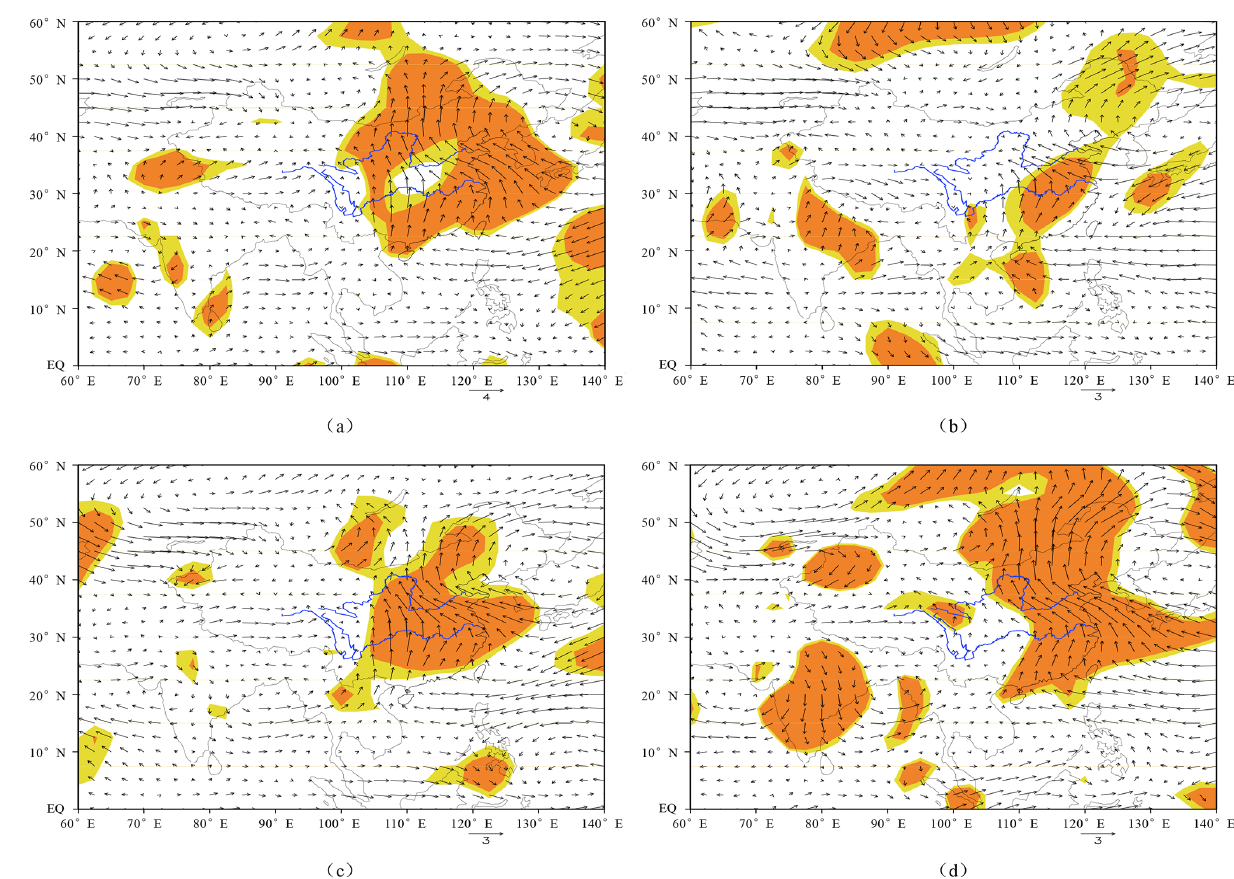
Figure 3. The differences between the wind anomaly fields at 850hPa for the years with extremely excessive precipitation and those for the years with extremely deficient precipitation in spring (a) , summer (b) , autumn (c) and winter (d) . (The yellow and orange parts respectively indicated the area passing the significance test at 0.1 and 0.05 levels.)